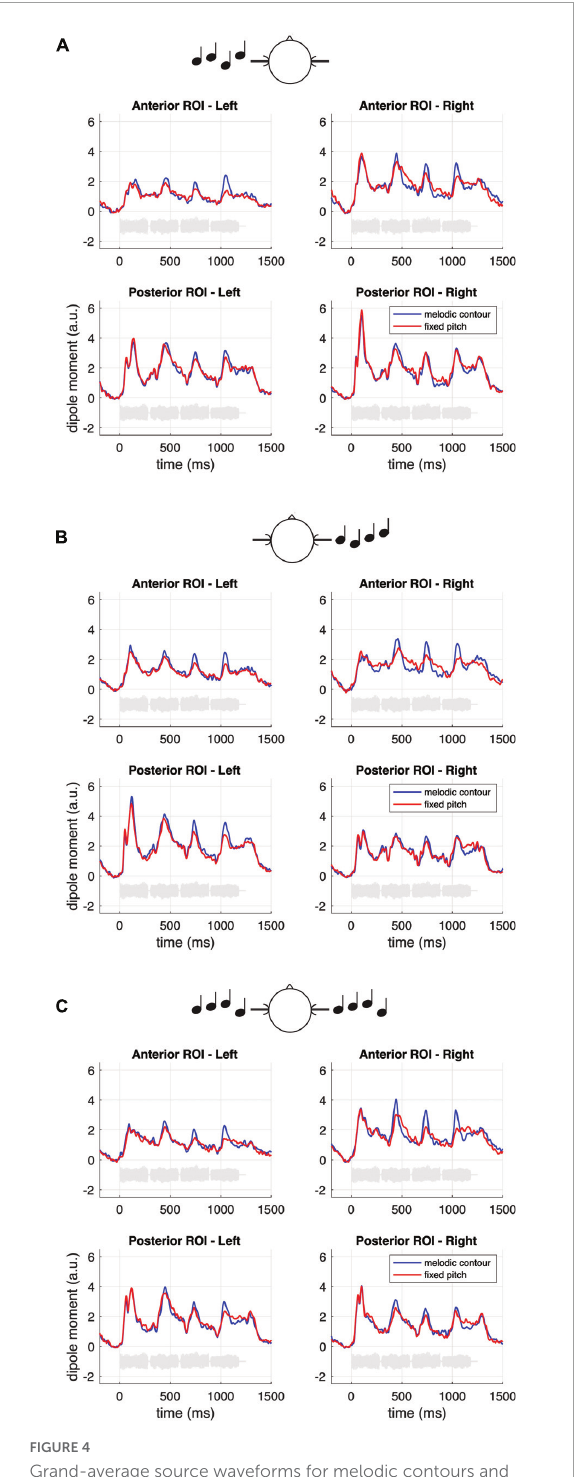
FIGURE4 Grand-average source waveforms for melodic contours and fixed pitch sequences, separately for the monaural left and right (A,B) and the diotic (C) listening conditions, and for the anterior and posterior ROIs. The data represent pooled source waves extracted from the pre-defined ROIs (cf. Materials and methods). The light gray curves in each subplot represent example sound waveforms from the